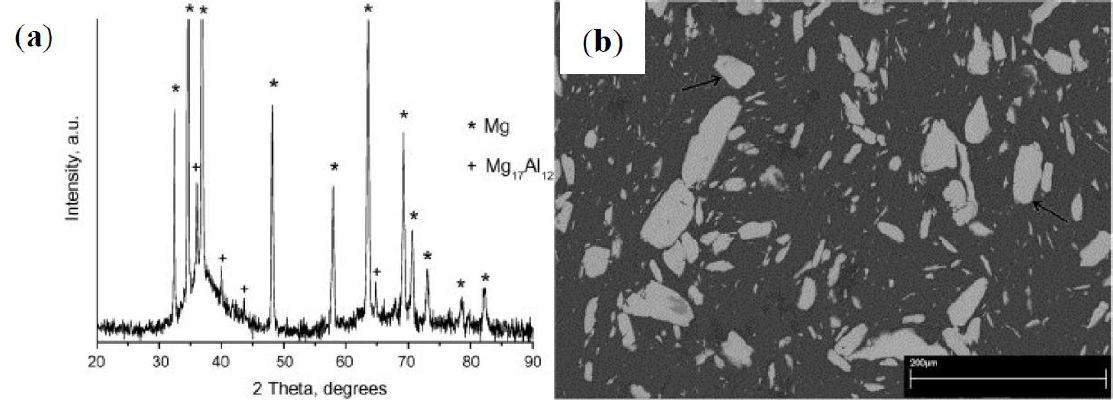
Figure 11. ( a ) X-ray diffractograms and ( b ) SEM micrograph of Zr-based glassy particle reinforced AZ91 Mg-alloy composite prepared by high frequency induction heating under pressure. Metallic glass particles are marked with black arrows in ( b ) (reprinted from Dudina et al . 2009 [15], with permission from ©